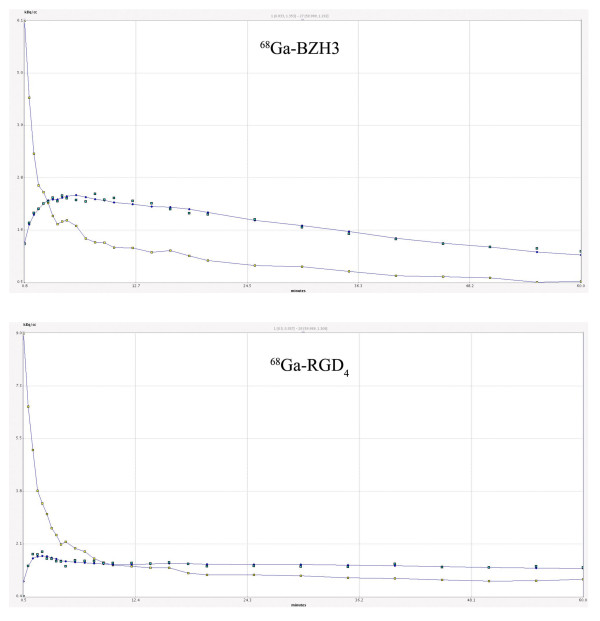
Representative blood input function (filled yellow squares) and tumor tissue tracer concentrations. Obtained in a 60-min acquisition sequence (left, 68Ga-BZH3; right, 68Ga-RGD4). Filled green squares are tracer concentrations for each image, while the smooth line through the data is the two-tissue-compartment model fit to the data. A smooth line (interpolation) was drawn through the input function data to illustrate the shape of the curve.